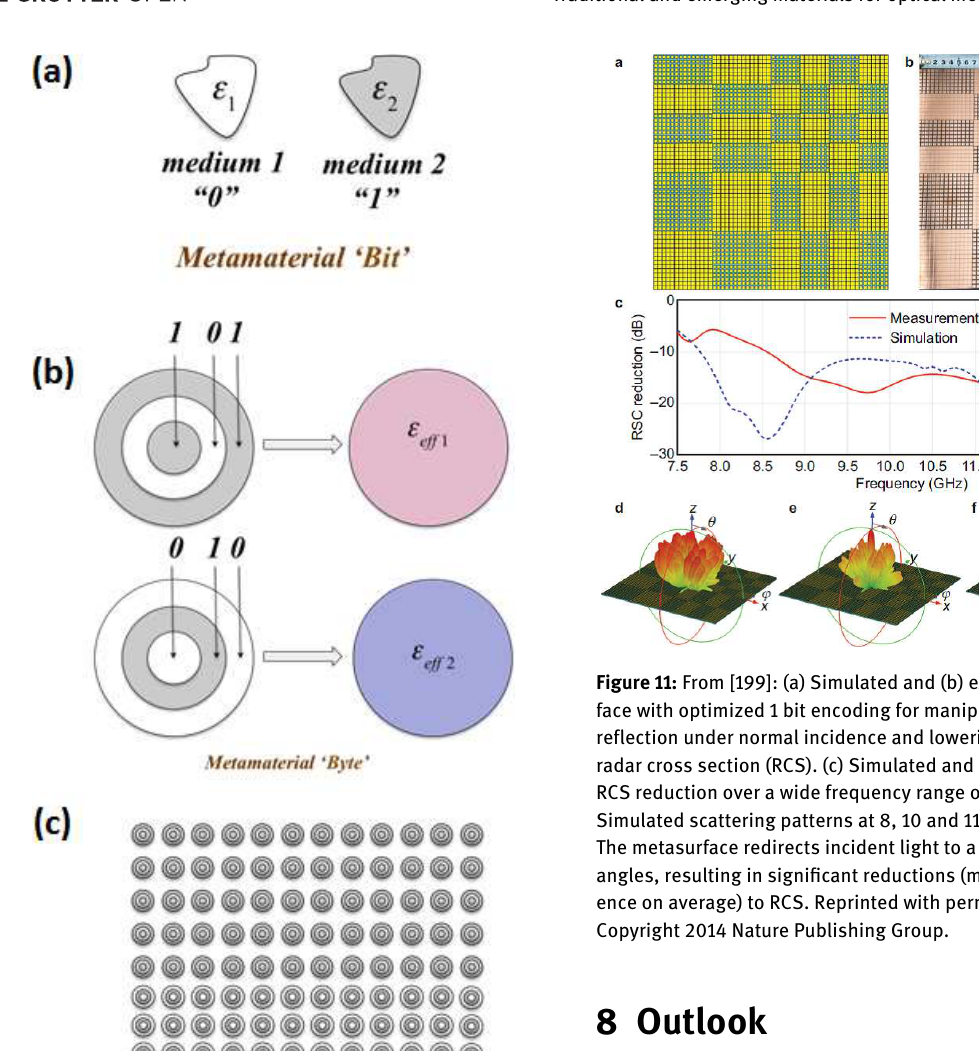
sponse to external stimuli, which paves the way for more complicated operations that are in line with the general, overarching concept of computational metasurfaces.